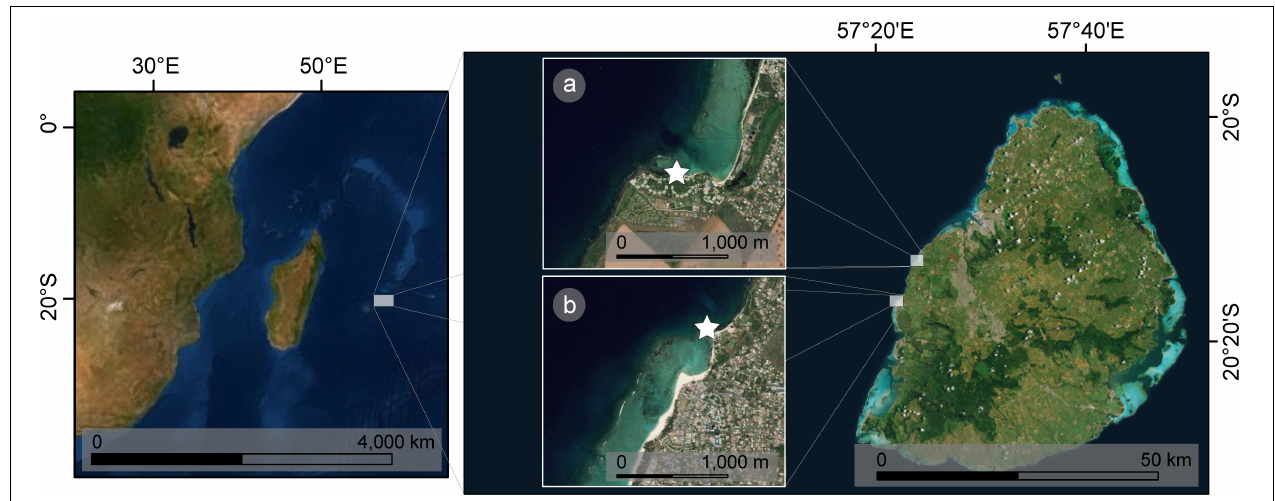
FIGURE 1 | The island of Mauritius in the South-West Indian Ocean with the two sampling tide pools at its West coast: Stars mark the locations of (A) a tide pool influenced by submarine groundwater discharge at Albion, (B) a strictly marine tide pool at